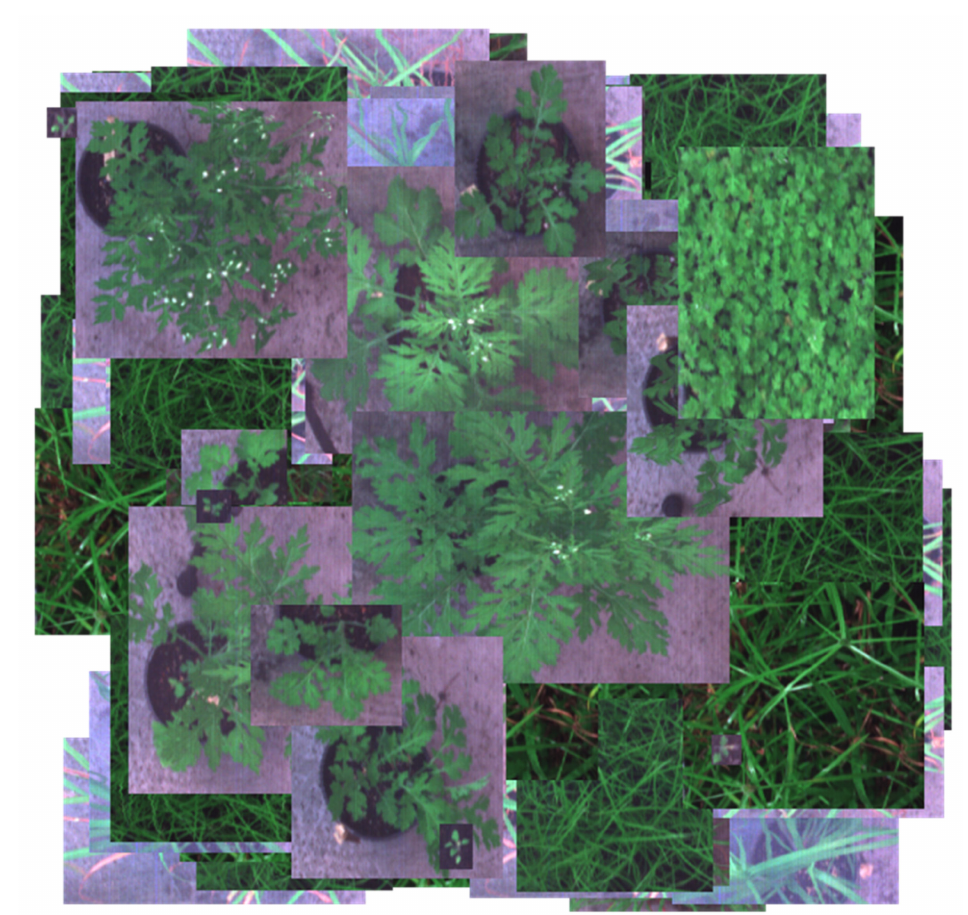
Figure 7. Combined hypercube with seedling, rosette, and flowering parthenium weed plants over non-parthenium